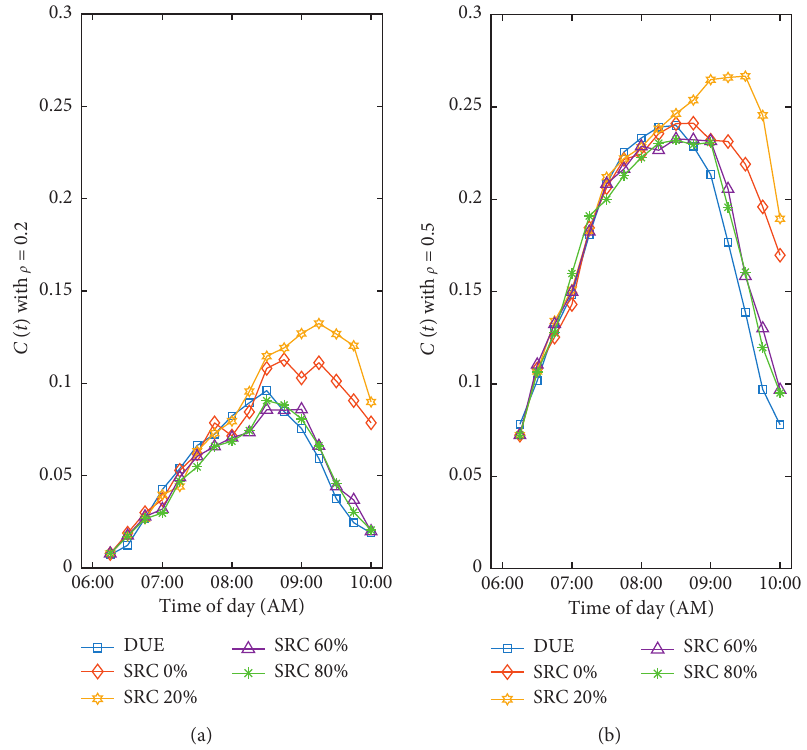
Figure 9: Congestion propagation and dissipation in the network from 06:00 AM–10:00 AM represented by the fraction of congested links C ( t ) with (a) congestion threshold ρ � 0 . 2, (b) congestion threshold ρ � 0 . 5.